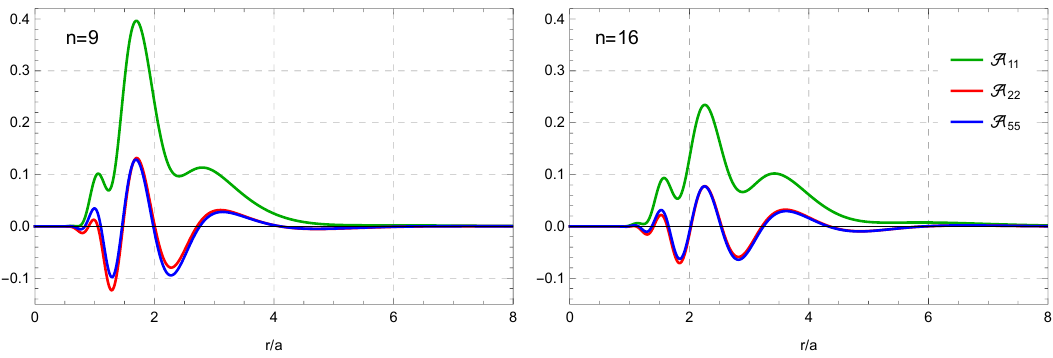
√ Figure 3 . Plots of A 11 , A 22 and A 55 with ˜ b ≡ b/ 2 a = 100 and n = 9 (left) and n = 16 (right). The curves are rescaled by ˜ b 2 and given in units of a 2 . We observe oscillatory behaviour in all three mass matrix elements. While A 11 is always positive, A 22 and A 55 are negative in some regions. The tidal forces along the toroidal directions are not negligible compared to other